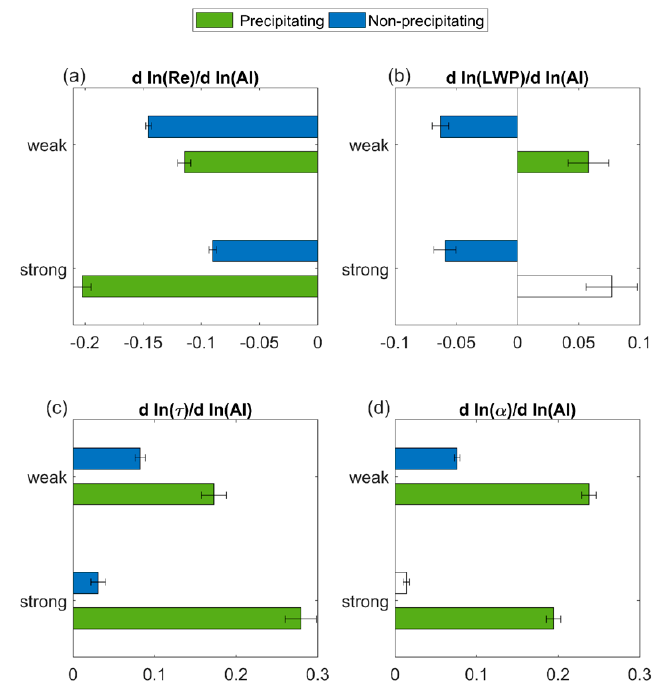
Figure 9. The cloud susceptibility to aerosol index (AI) under weak and strong inversion strengths. The cloud parameters were: ( a ) Cloud droplet effective radius (Re), ( b ) Cloud liquid water path (LWP), ( c ) Cloud optical depth, and ( d ) Cloud albedo. The threshold value for weak and strong inversion was defined as EIS < 25th percentile and EIS > 75th percentile, respectively. Response for precipitating and non-precipitating clouds are shown in green and blue, respectively. All the filled bars are statistically significant at a 95% significance level. The error bars were calculated based on the standard error of the regression slope.